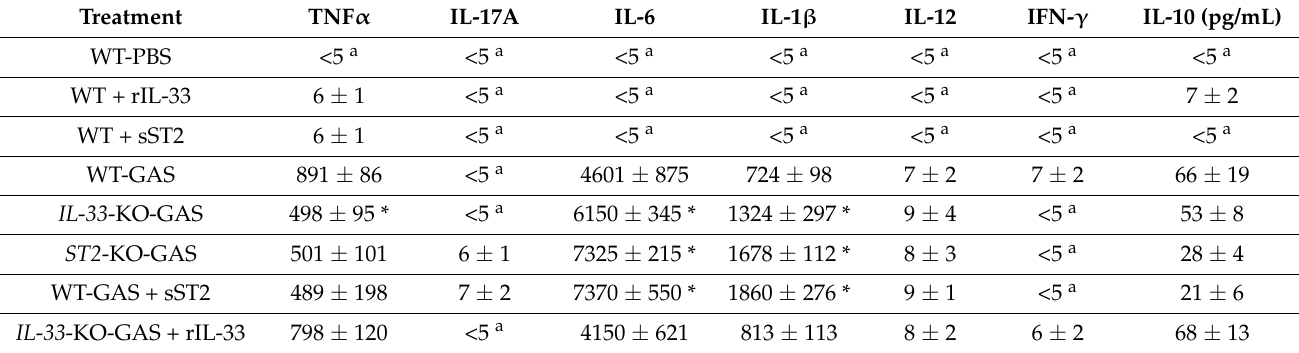
Table 1. Cytokine expression in exudates of mouse air pouches after GAS